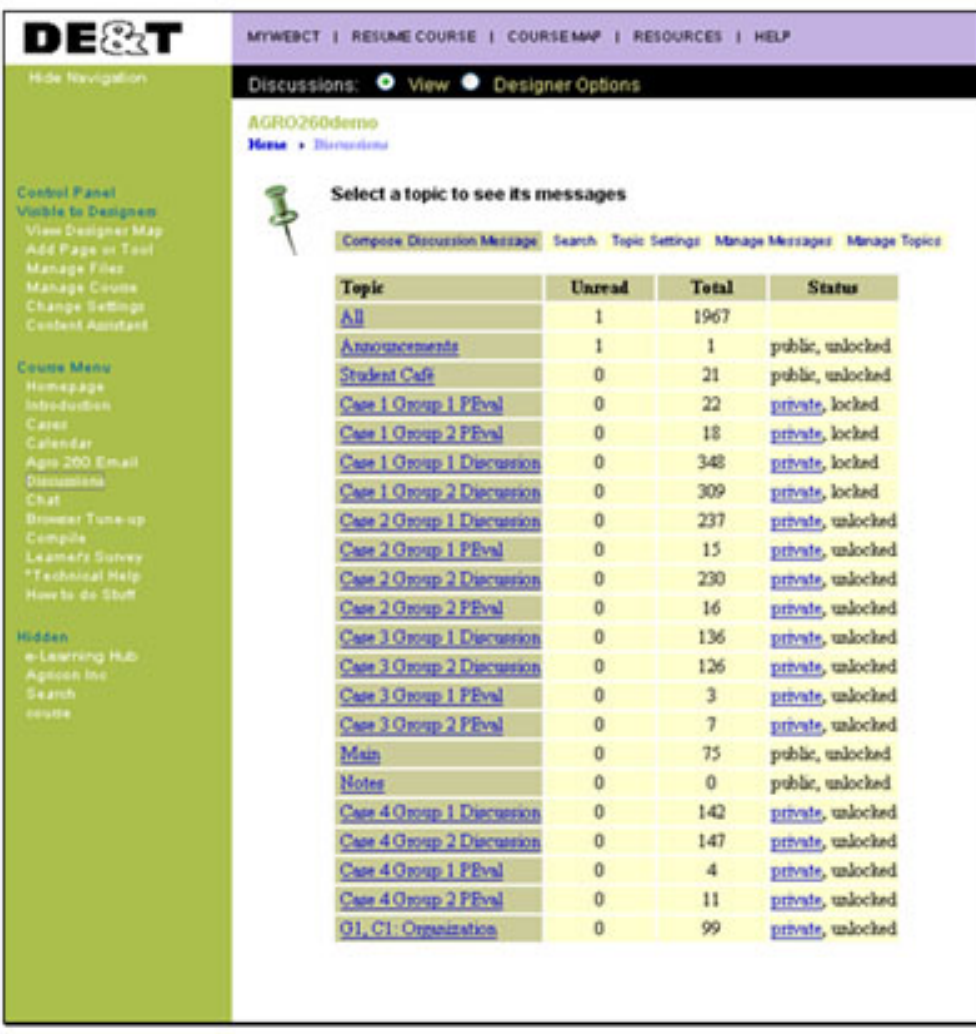
Figure 2. AgroEcology discussion